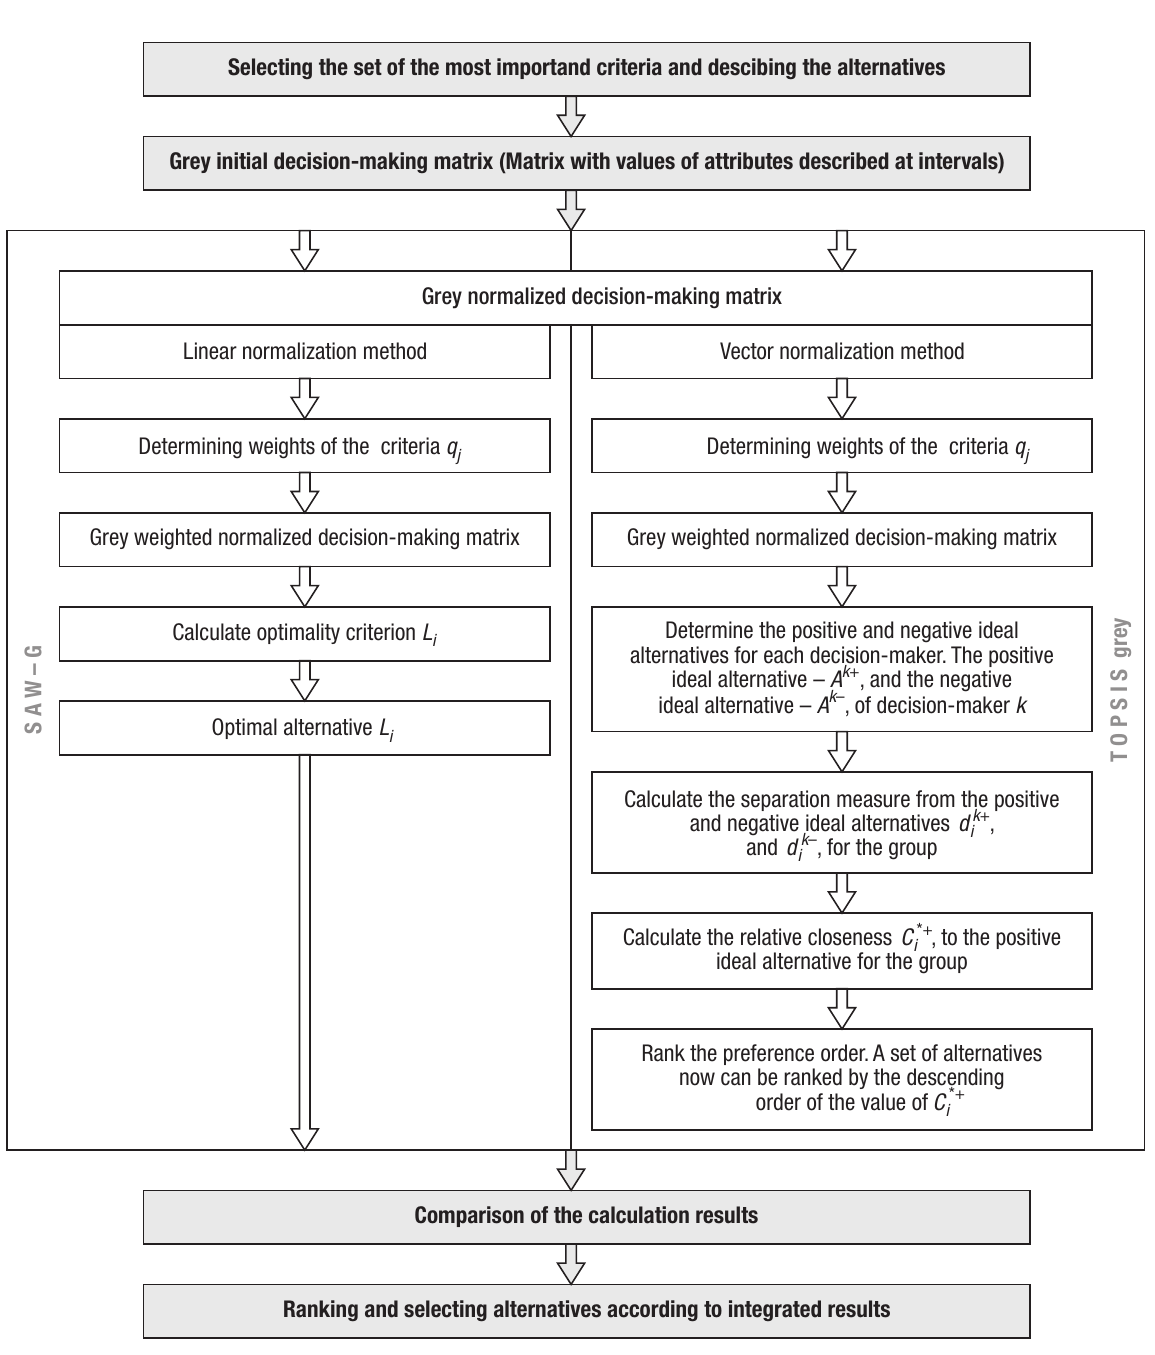
Ranking and selecting alternatives according to integrated